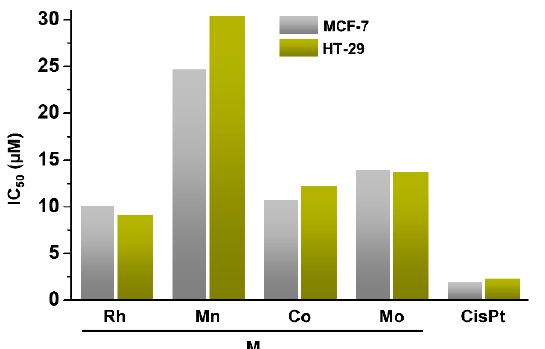
Figure 12. Comparison of in vitro antiproliferative activity of complexes [M( η 5 -Cp as )(CO) 2 ] (see Figure 8 for the structural formula of the Rh complex) against the MCF-7 breast carcinoma and HT-29 colon carcinoma cell lines. Cp as = (cyclopenta-1,3-dienyl)propyl-2-acetoxybenzoate, CisPt = cisplatin.